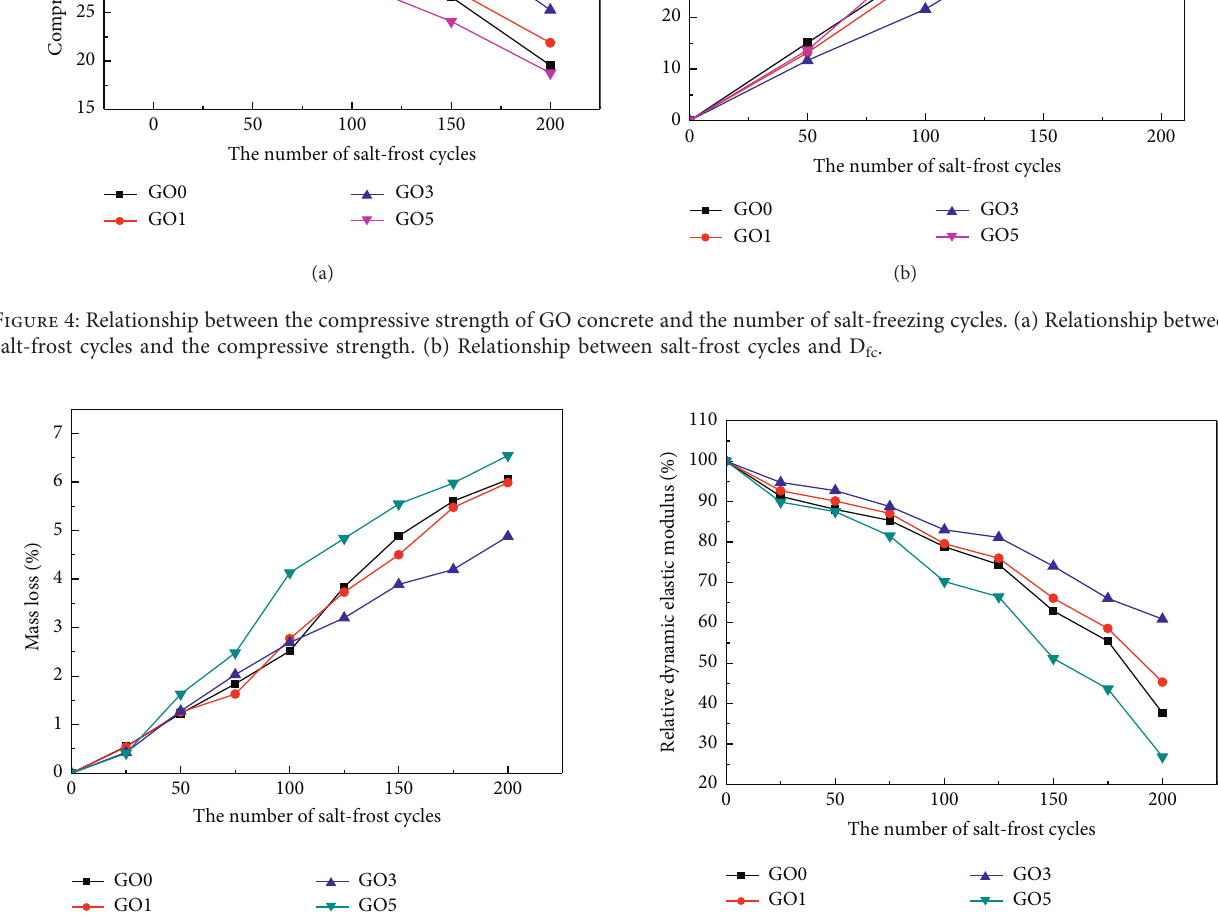
Figure 6: Dynamic elastic moduli of concrete under different salt- freezing cycles.